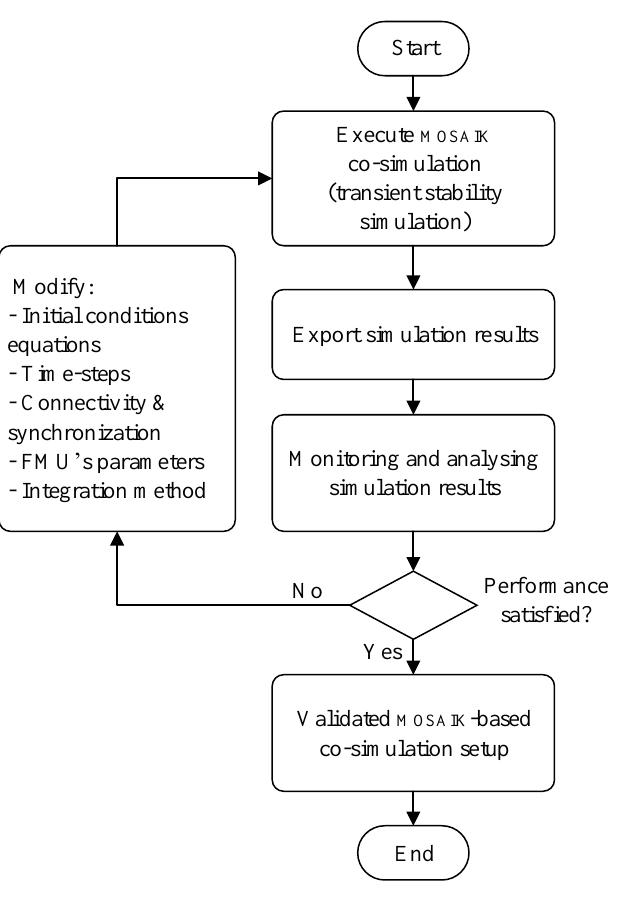
Figure 8. Workflow diagram of the co-simulation setup using MOSAIK and the